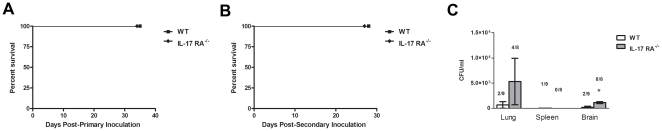
Lack of IL-17R signaling does not significantly affect resolution of infection or survival to cryptococcal infection.BALB/c mice or IL-17RA−/− mice received an intranasal inoculum of C. neoformans strain H99γ. Mice were assayed for survival through 35 days of primary infection with C. neoformans strain H99γ (A). Surviving mice were then challenged with C. neoformans strain H99 and assayed for survival through 28 days of secondary challenge (B). Culture of lung, spleen, and brain tissues at day 28 post-secondary challenge were determined from mice with positive cultures (C) and numbers of mice with positive cultures are shown above each bar. Survival data show one experiment containing nine WT and eight IL-17RA−/− mice. Asterisks (*) indicate where significant differences in fungal burden were observed in IL-17RA−/− mice compared to WT mice following infection with C. neoformans strain H99 (P<0.0001).